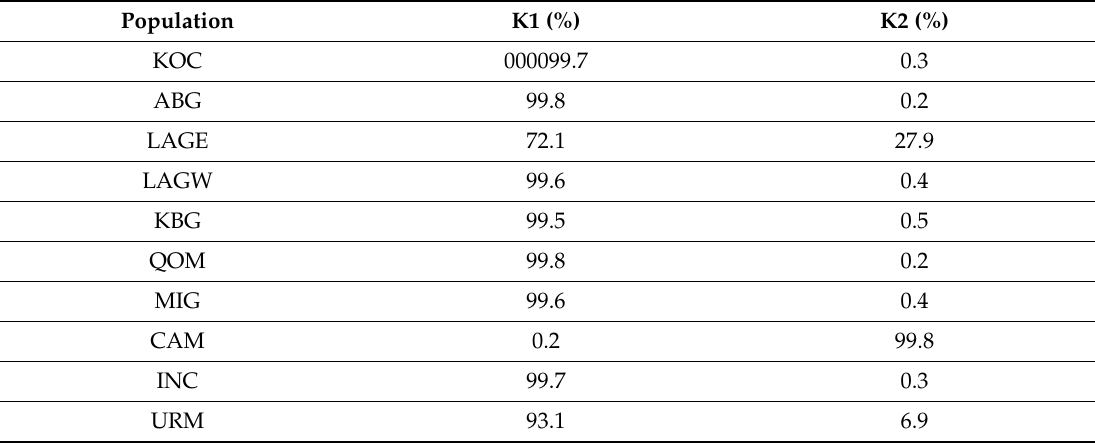
Proportion of genetic clusters for each locality in STRUCTURE analysis among native populations.